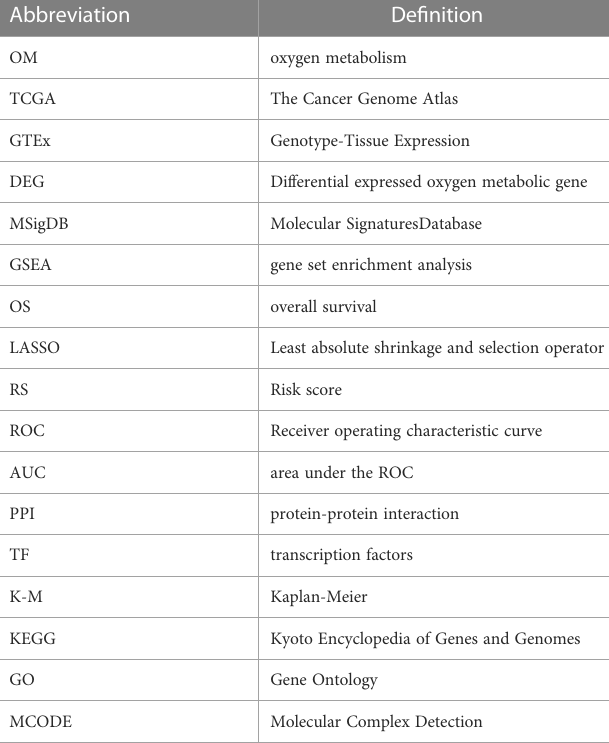
TABLE 1 List of abbreviation used in this